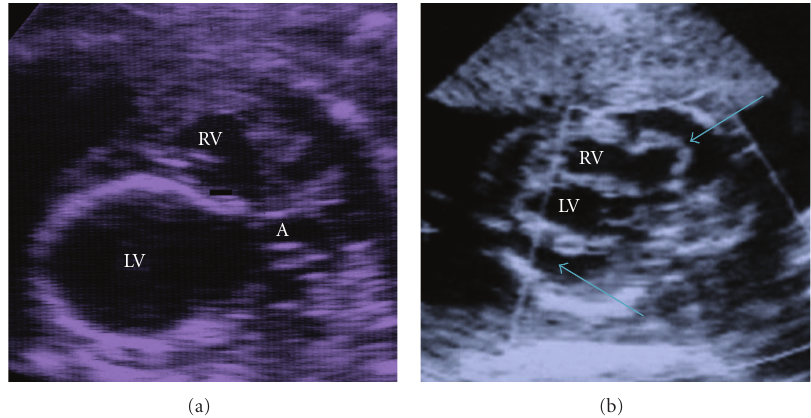
Figure 1: (a) Echocardiography of a fetus with endocardial fibroelastosis—a high echodensity of the left ventricular (LV) walls due to calcifications is evident. RV—right ventricle, A—aorta. (b) Fetus with myocarditis and fetal hydrops: both ventricles and atria are dilated and the arrows indicate the pericardial e ff usion. RV—right ventricle, LV—left ventricle.